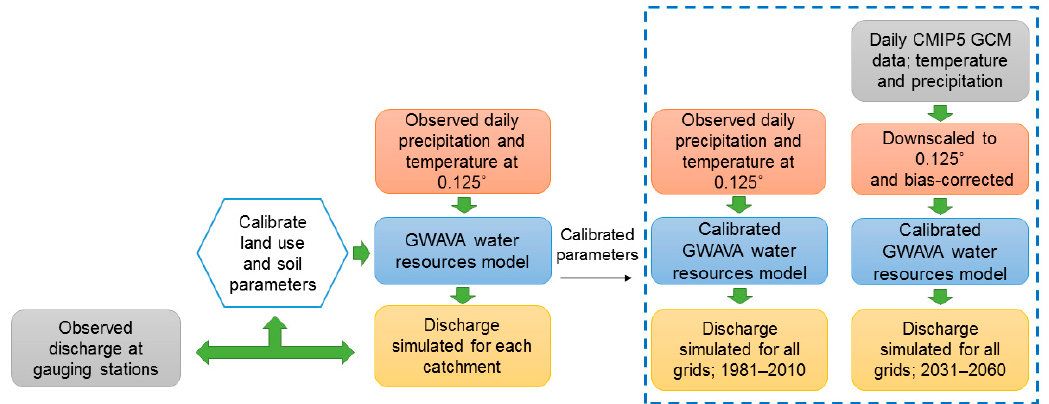
Figure 3. Methodology used for assessing the impact of climate change in the Upper Narmada. Table 4. Model performance statistics at the eight gauges for the calibration and validation periods.